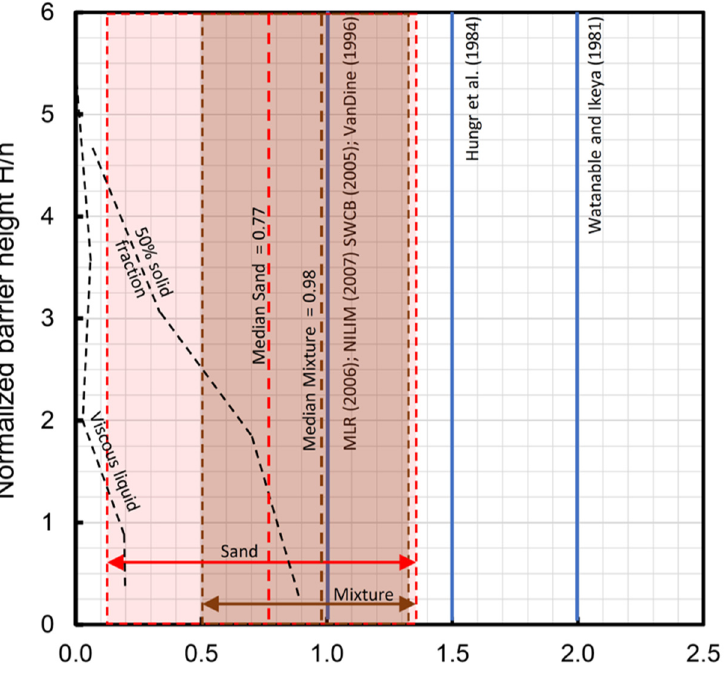
Figure 15. Dynamic coefficient α according to [22] with the addition of the experimental results of this